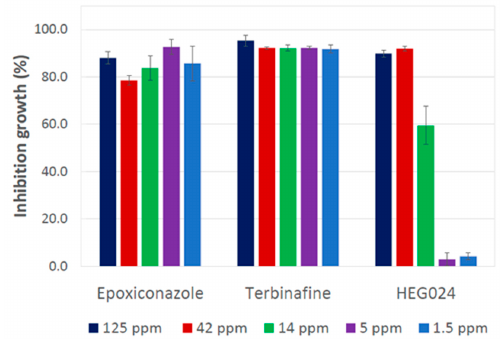
Figure 6. Inhibition percentage of growth of B. cinerea by the crude extract (HEG024) from the culture broth of C. virescens in vitro at different concentrations in ppm, after eight days of pathogen inoculation. Epoxiconazole and Terbinafine were used as positive control. Mean and standard deviation is expressed in the error bar (n = 3). Figure 7 shows the antagonistic effect of crude ethyl acetate extract from the culture broth of C. virescens against S. tritici . The crude showed stronger inhibition at concentra- tions of 125 and 42 ppm.